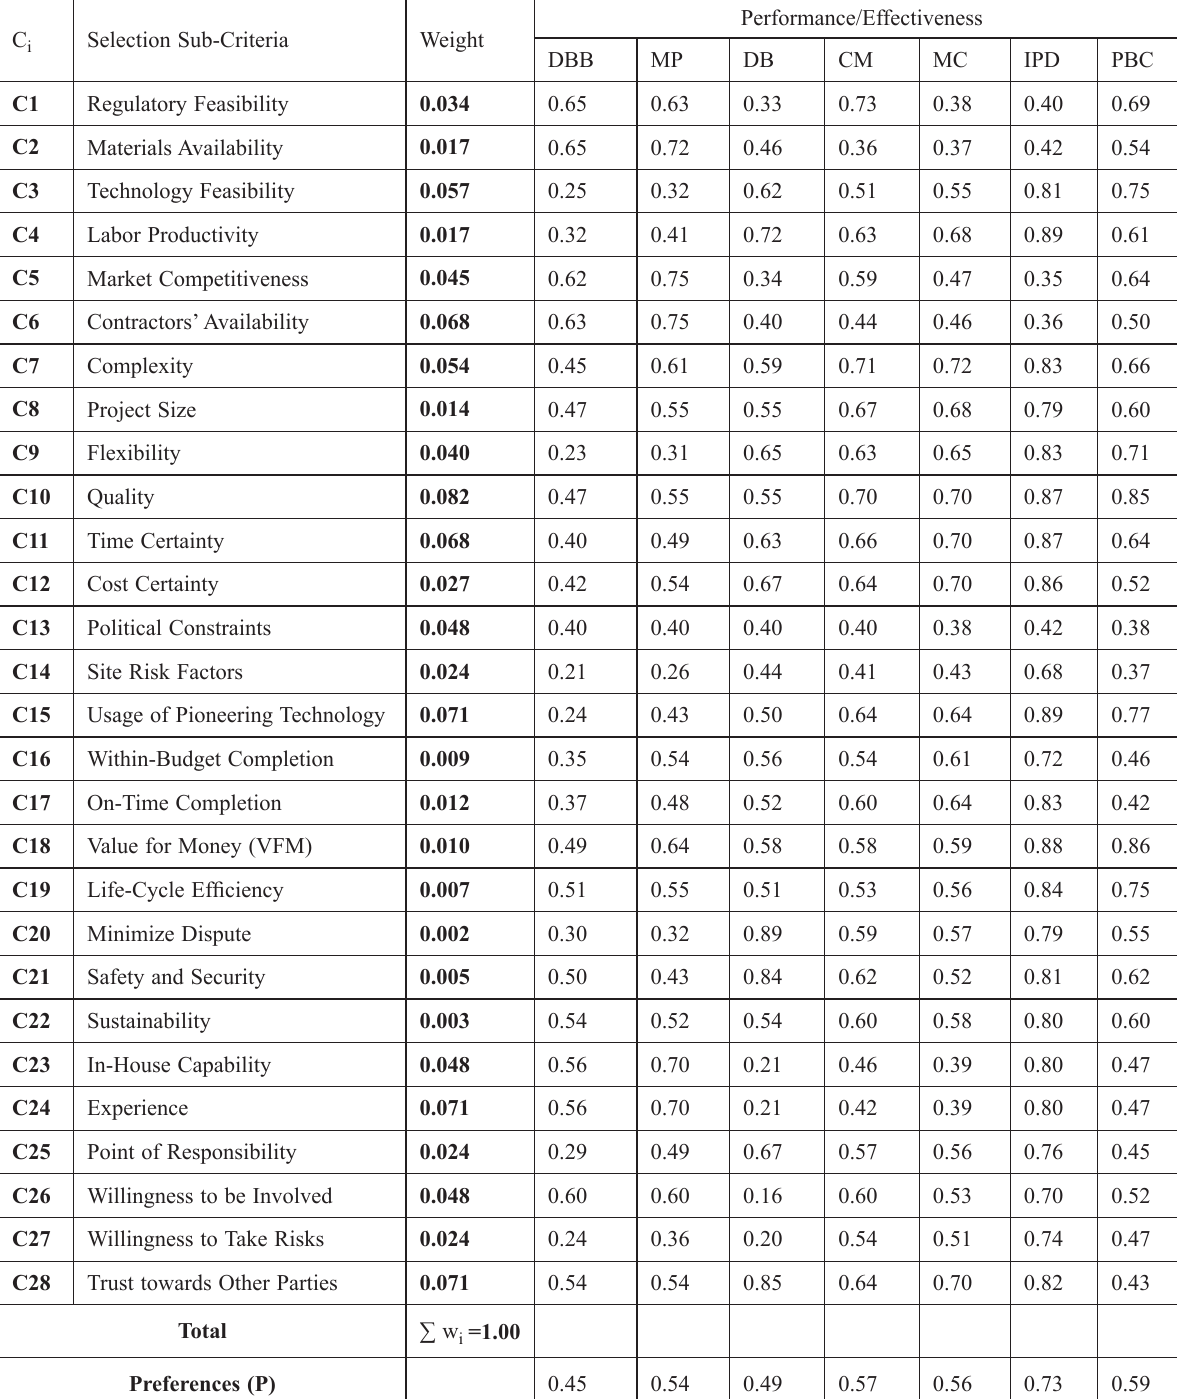
Table 3. Metrics of aggregate scores/preferences of alternative procurement/delivery systems with respect to W1 C i Selection